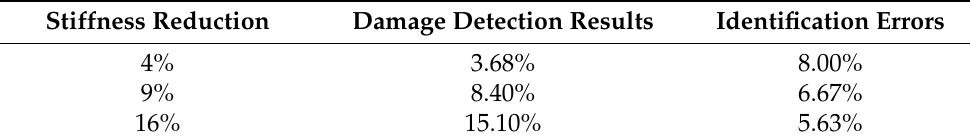
Figure 11. Damage detection results under 16% damage condition. Table 2. Damage detection results with the load applied on node 11.